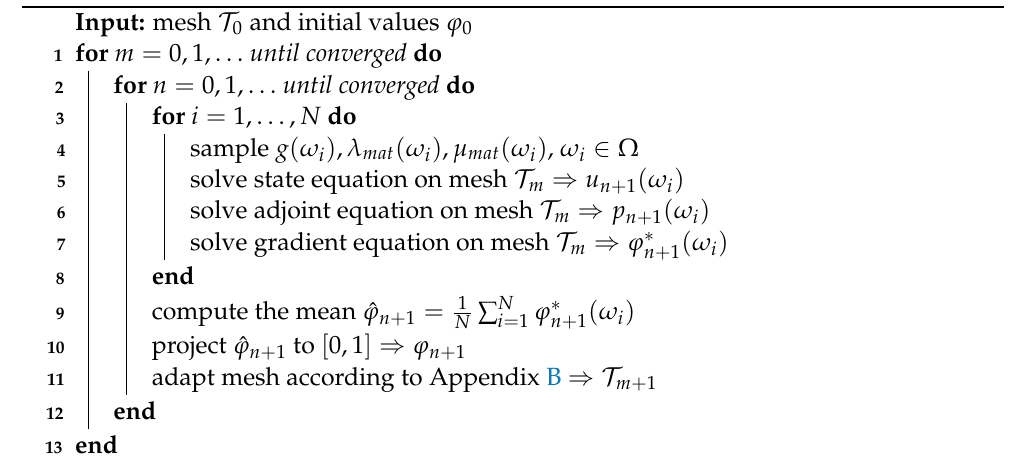
Algorithm A2: Stochastic optimisation algorithm from